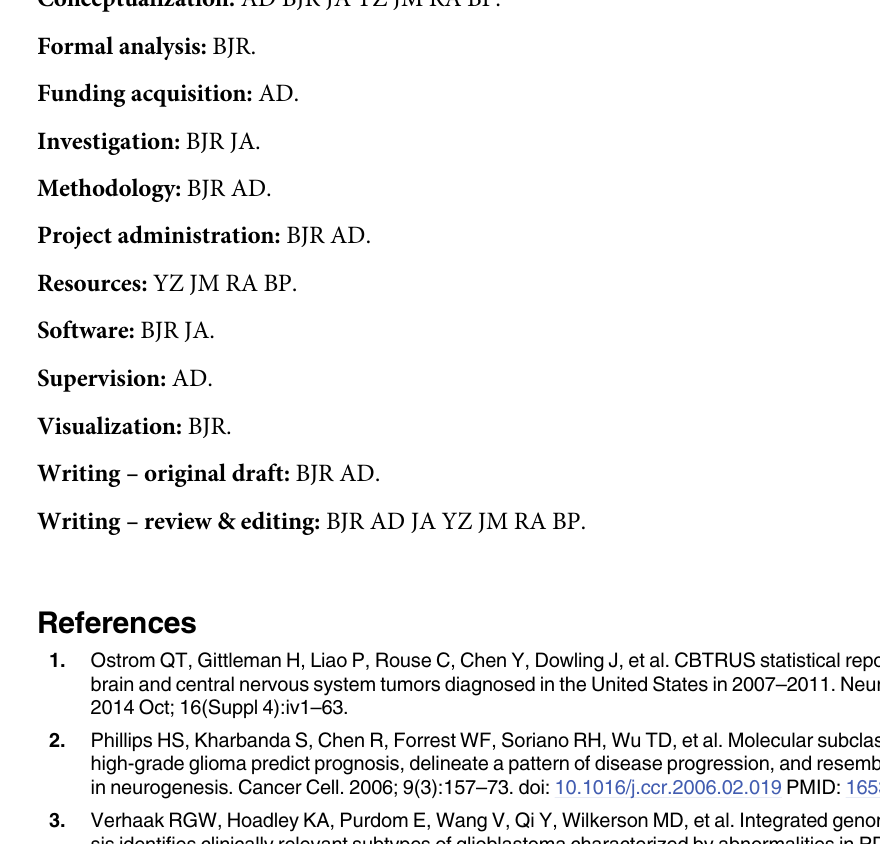
S7 Table. LGG and GBM patient characteristics. S8 Table. Patient characteristics of the test and validation sets of LGG patients. S9 Table. Cox coefficients and p -values of prognosis-associated lncRNAs in GBMs. (XLSX) S1 Text. STROBE